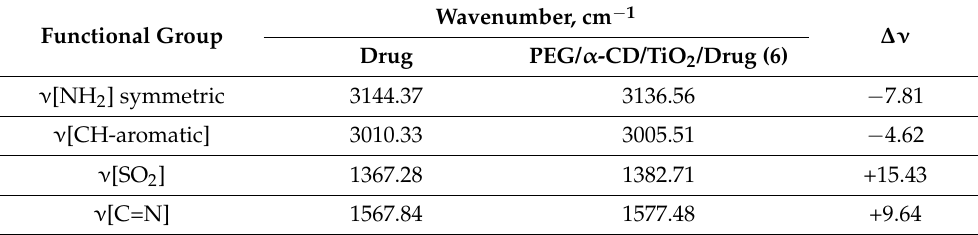
Figure 3. FT-IR spectra of the drug (green), PEG/TiO 2 / α -CD (black), and PEG/TiO 2 / α -CD/Drug (red). Table 4. FT-IR difference between drug before and after loading on pseudopolyrotaxane composite.